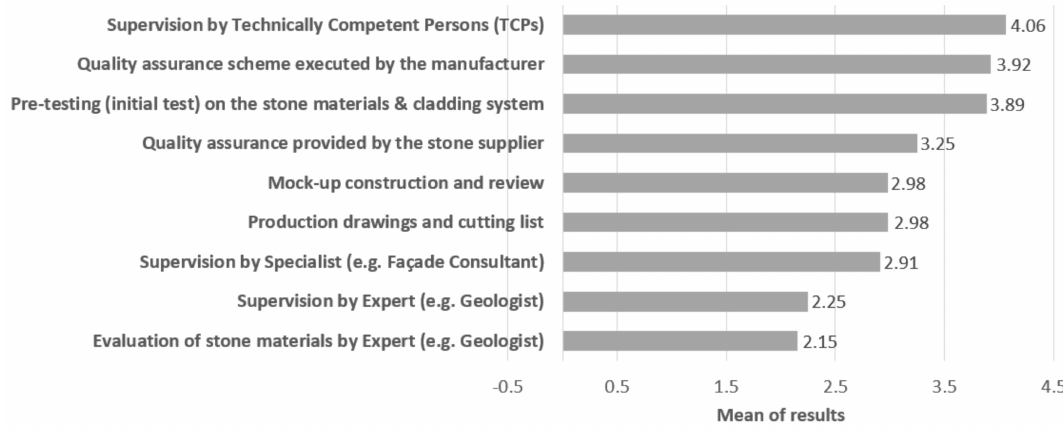
Figure 7. Factors to ensure the quality in the production stage ( n =